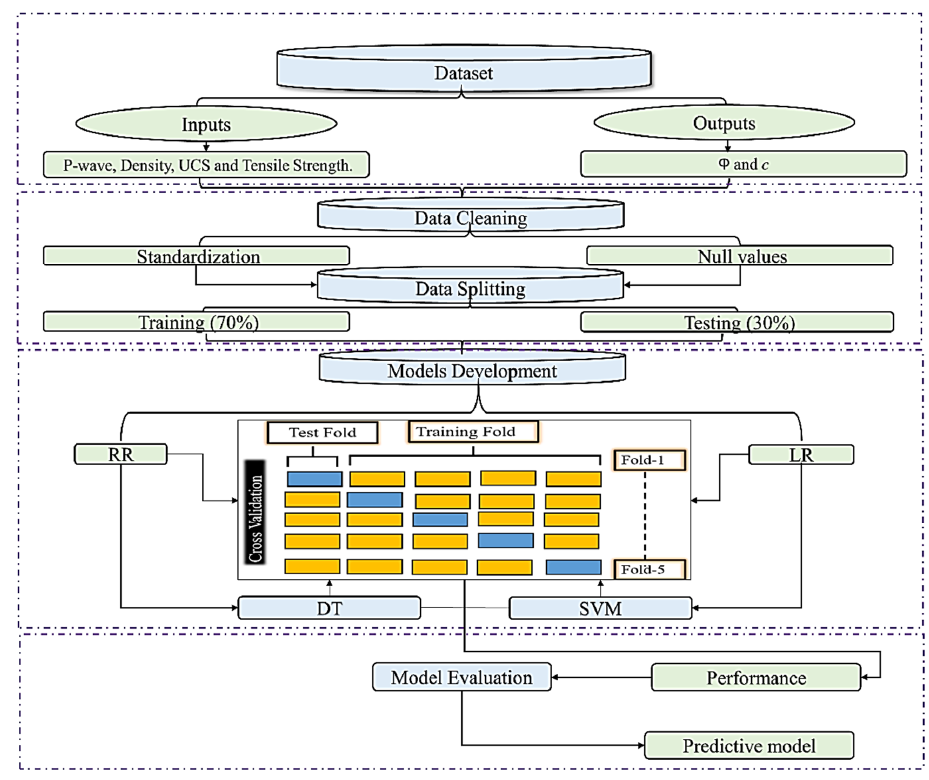
Figure 1. Flowchart of the ML-based intelligent approach in this study.